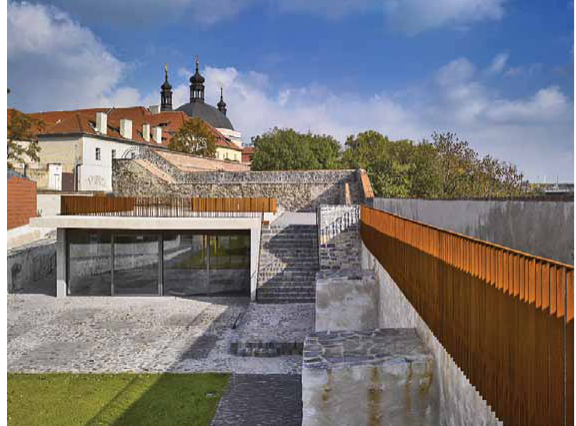
fig. 8. Miroslav Cikán, Pavla Melková: reconstruction of Bastion XXXI., Prague, 2012. f. Šlapal